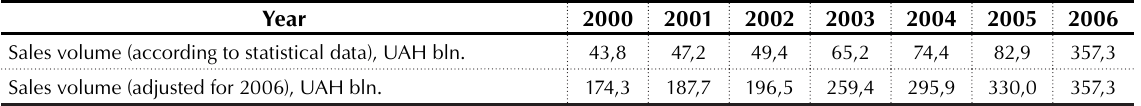
Table 1. Sales volume of small business during 2000–2006, adjusted for 2006